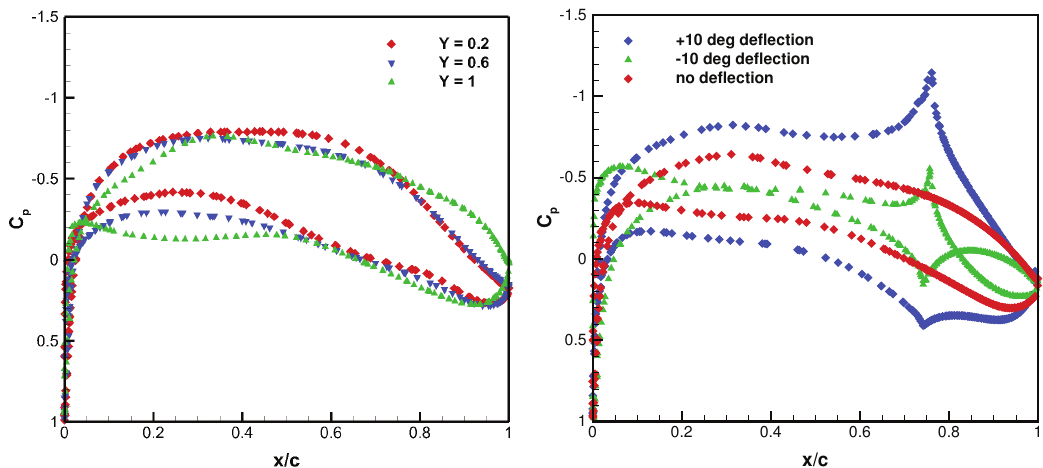
Figure 18. Pressure coefficient at different wing sections ( left ), and at half-span aileron section ( right ), for different deflections.